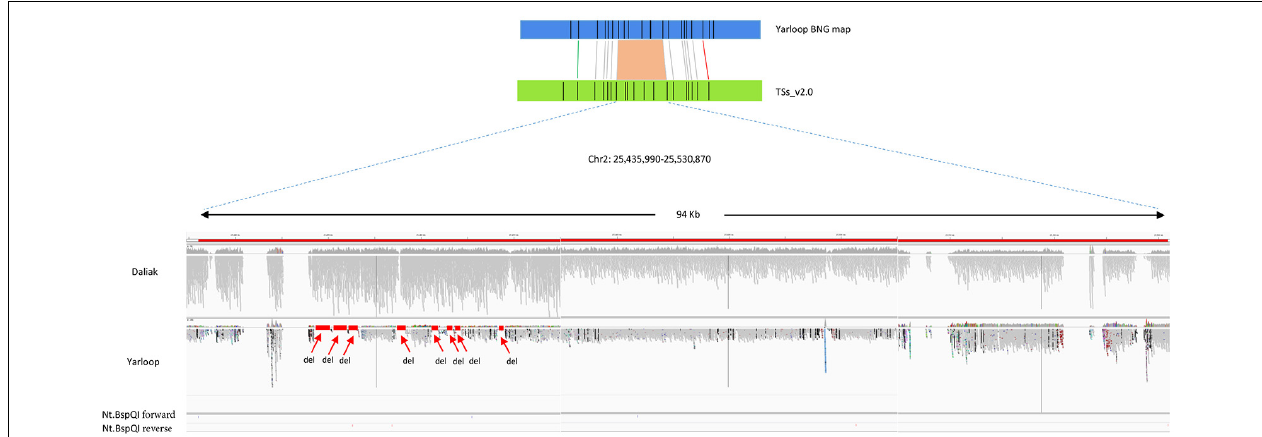
FIGURE 1 | An example of deletions detected by Bionano optical mapping with nucleotide sequences validation. The region reported by Bionano contains deletion(s) in cv . Yarloop compared to the reference genome between location 25,435,990 b and 25,530,870 b in chromosome 2. The gray bars in this figure represents short reads aligned to the reference. Other color dots means different SNPs. Nt.BspQI forward represents sequence: GCTCTTC and Nt.BspQI reverse represents sequence: GAAGAGC. The size of the deletion reported by Bionano is 6.6 kb. From the nucleotide-level validation, eight small deletions (displayed as ‘del’) were visualized in the IGV with no sequence reads aligned to the reference genome. The total size of those eight small deletions is 6.1 kb. The eight small regions were supported in the Lumpy SV calling. The regions having zero coverage are the gaps in the